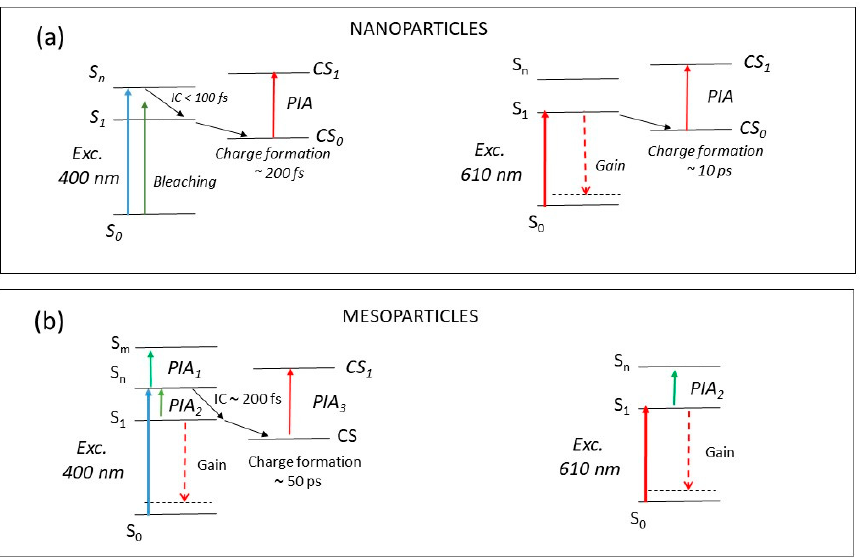
Figure 5. Schematic energy diagrams for the nanoparticle ( a ) and mesoparticle; ( b ) polymer films, where CS indicates the charged state and IC is an internal transition.